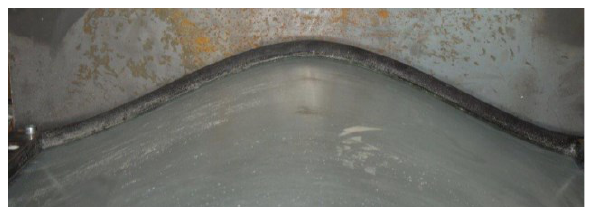
Fig. 6 . Experimental measurement: detail of